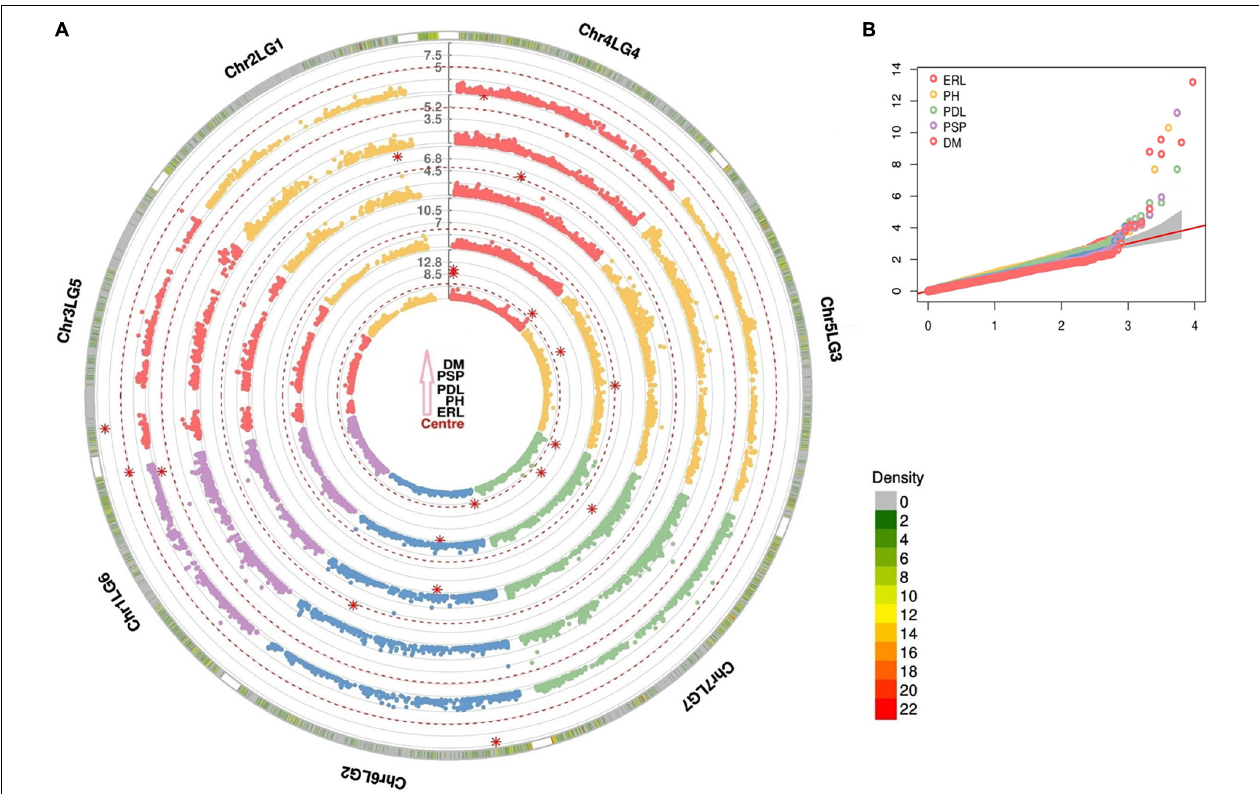
FIGURE 5 | Circular Manhattan (A) and Q-Q plots (B) of six different traits from fixed and random model circulating probability unification (FarmCPU)-genome-wide association study (GWAS) model incorporating the first two PCs and cryptic relatedness as covariates. The red dash lines and red stars are the Bonferroni threshold and MTAs above the Bonferroni threshold, respectively. Earliness (ERL), plant height (PH), pod length (PDL), percent of small wrinkled vining peas (PSP), downy mildew